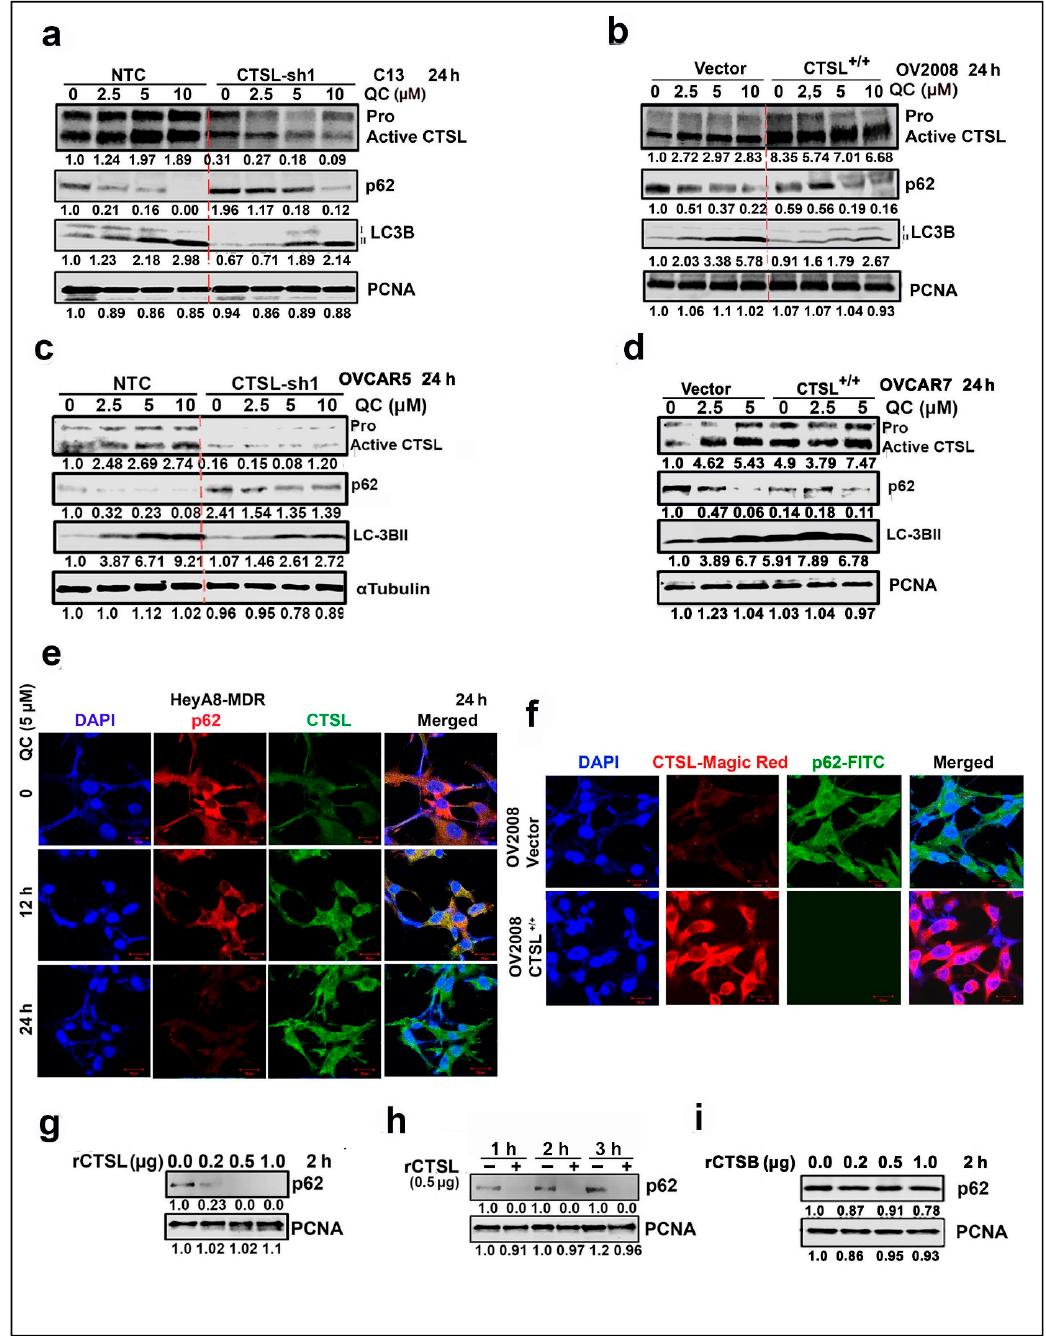
Figure 5. QC-upregulated CTSL drives the autophagic flux by degrading p62. ( a , c ) Western analysis in the CTSL KD sh1 clone of C13 and OVCAR5 cells upon treatment with 2.5, 5 and 10 μ M QC for 24 h against CTSL, LC3BII and p62 proteins. ( b , d ) Similar immunoblot analysis in the CTSL-overexpressed OV2008 and OVCAR7 cells for the mentioned proteins. ( e ) Confocal analysis for CTSL (green) and p62 (red) was performed in the HeyA8-MDR cells upon treatment with QC for 12 and 24 h (Scale bar: 20 µm and 40× magnification). ( f ) Magic Red staining for CTSL activity assay and p62 labeling was done in the OV2008 control transfected and the CTSL-overexpressed cells, and representative images of confocal analysis are provided (Scale bar: 20 µm and 40× magnification). ( g ) Western analysis against p62 protein was performed in the HeyA8-MDR cells upon incubation with rCTSL at 0.0, 0.2, 0.5 and 1.0 µ g/sample for 2 h. ( h ) Similar Western analysis was performed upon treatment with 0.5 µ g rCTSL for 1, 2 and 3 h, respectively. ( i ) Western analysis against p62 protein was performed in the HeyA8-MDR cells upon incubation with rCTSB at 0.0, 0.2, 0.5 and 1.0 µ g/sample for 2 h. Abbreviations: QC: Quinacrine; CTSL: Cathepsin-L; LC3B: Light Chain 3B; p62: Ubiquitin binding Protein 62 and and PCNA: Proliferating Cell Nuclear